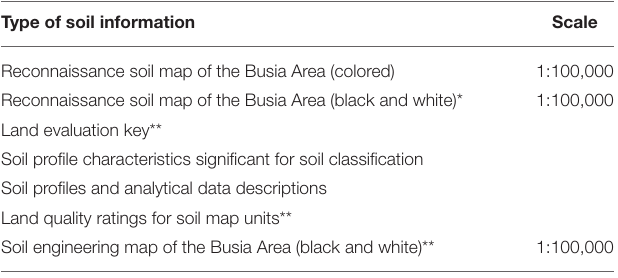
TABLE 1 | Soil information contained within the Reconnaissance Soil Survey of the Busia Area . Type of soil